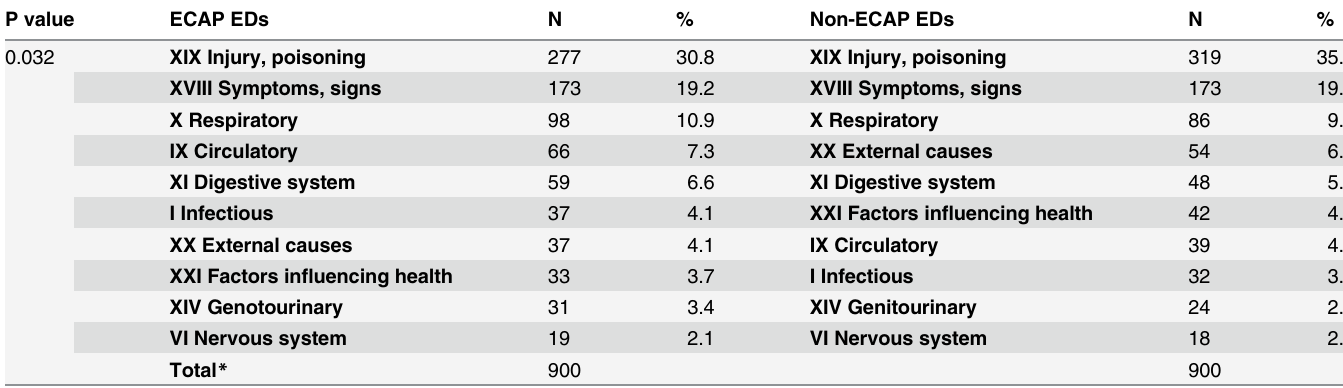
Table 5. ICD 10 Discharge diagnosis codes in each